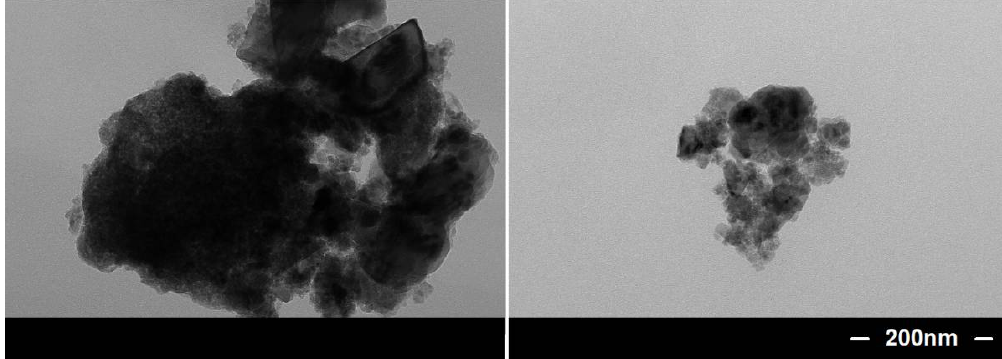
Figure 3. TEM image of Fe 2 O 3 -NCs.